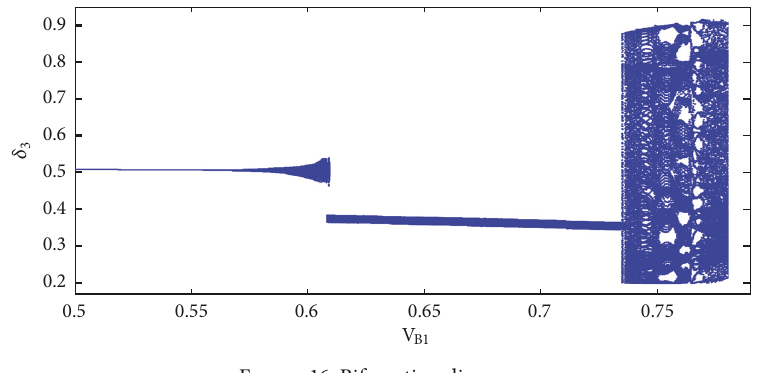
Figure 16: Bifurcation diagram.